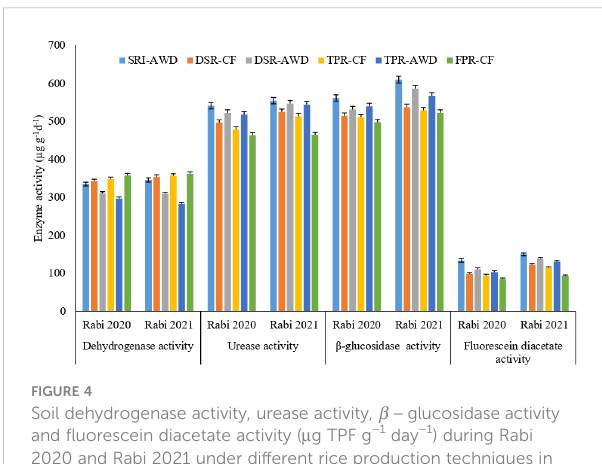
FIGURE 4 Soil dehydrogenase activity, urease activity, b − glucosidase activity and fl uorescein diacetate activity ( m g TPF g − 1 day − 1 ) during Rabi 2020 and Rabi 2021 under different rice production techniques in rice crop.